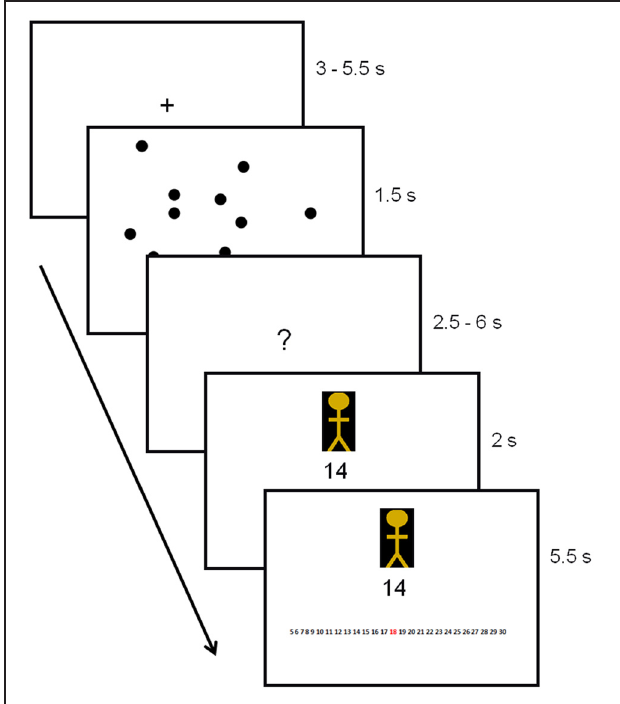
FIGURE 1 | Trial outline with duration times in seconds. Group membership of the other participant was indicated by the colored